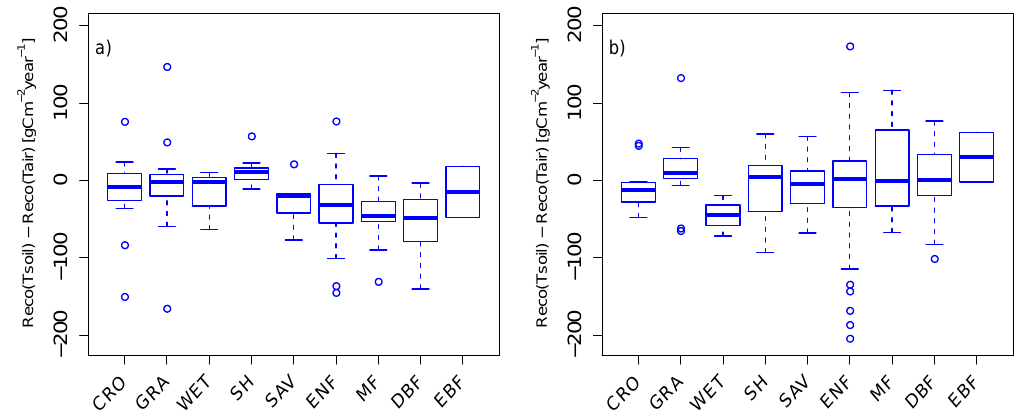
Fig. 12. Difference in annual R eco estimates using the Reichstein et al. (2005) approach (a) and the Lasslop et al. (2010) approach (b) , distinguished according to vegetation types (see Fig. 5 for vegetation types